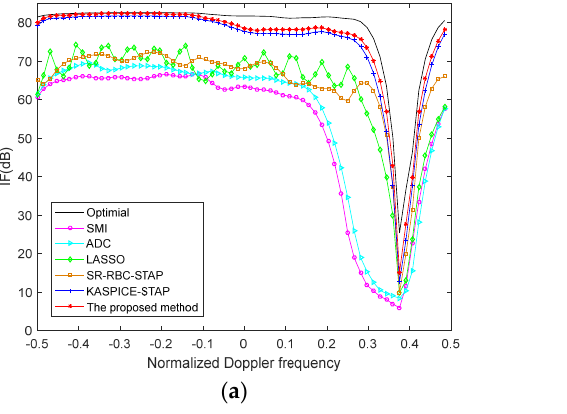
Figure 6. The IF versus normalized Doppler frequency with different methods ( a ) the model error are 0.5% amplitude error and 0.5° phase error; ( b ) the model error are 1.2% amplitude error and 1.2° phase error.